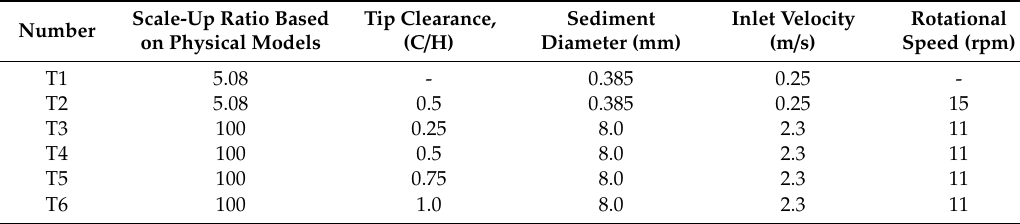
Table 3. Setup of numerical scour